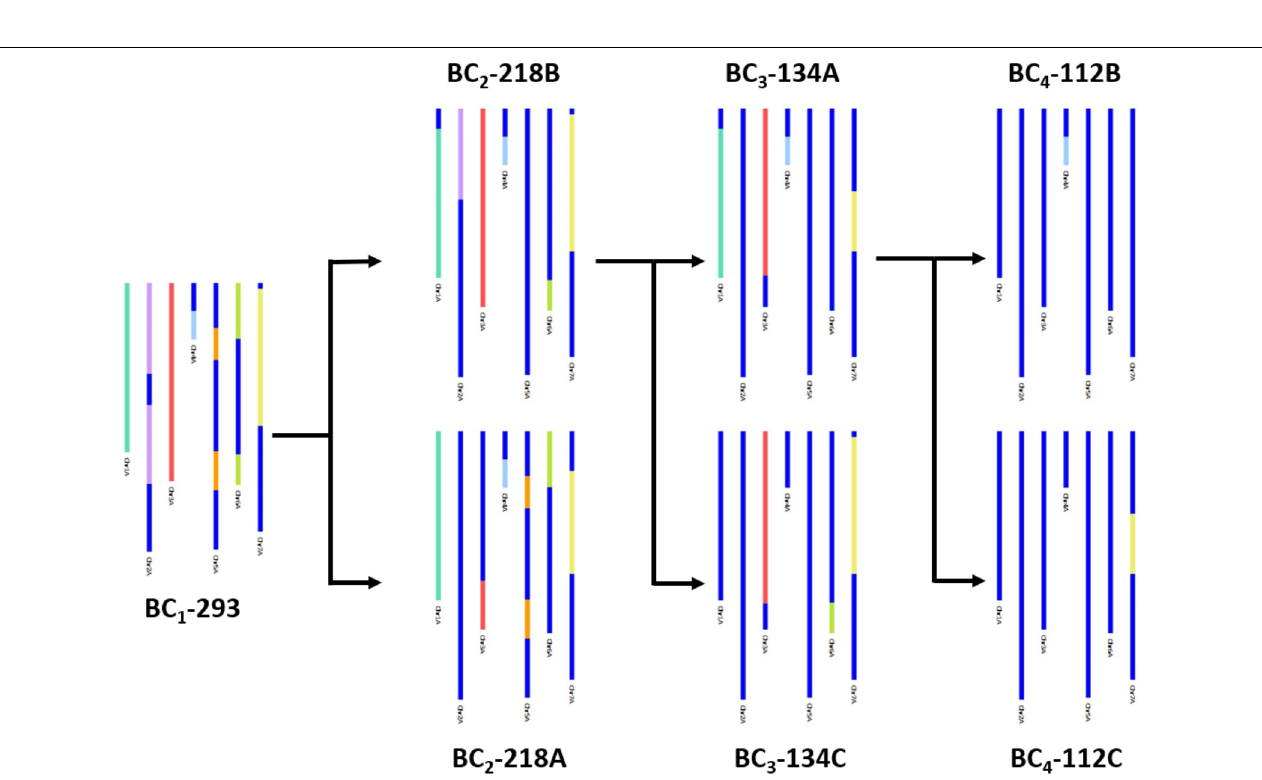
FIGURE 3 | A graphical representation of SNP characterisation of T. urartu introgressions into a hexaploid wheat background in four consecutive generations, i.e., BC 1 , BC 2 , BC 3 , and BC 4 , through GGT bar diagrams. Wheat genotype is represented in dark blue and T. urartu genotype is represented in a different color for each LG.